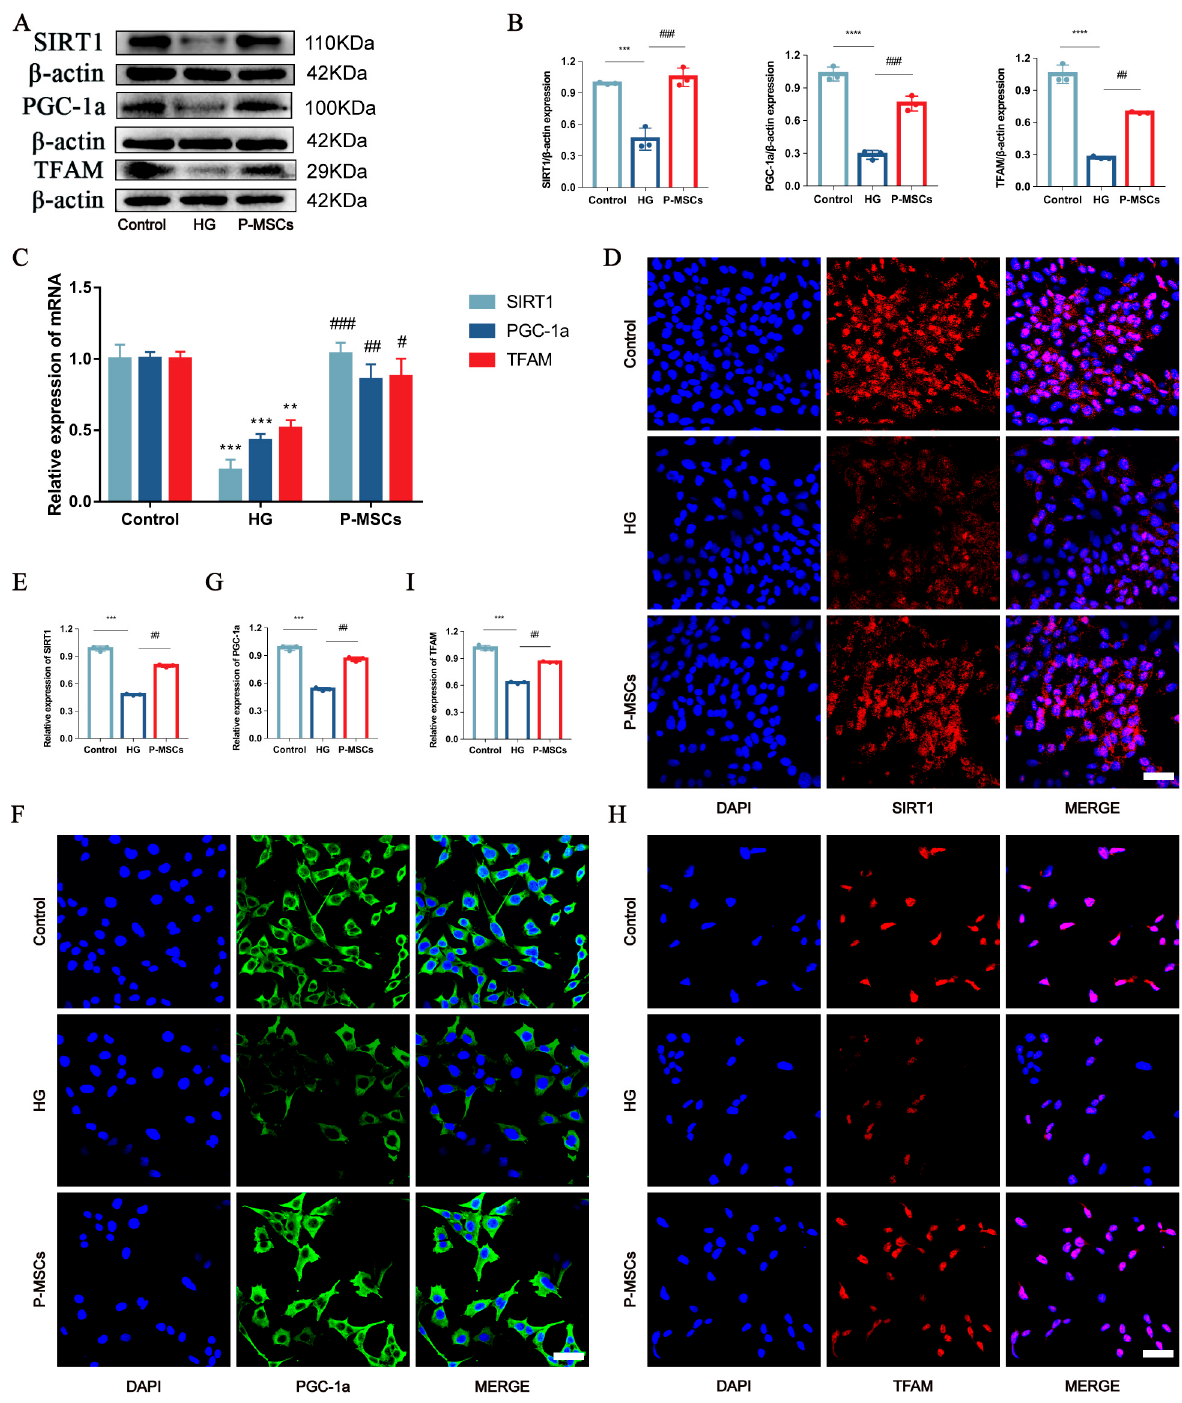
Figure 5. P-MSCs increased the expressions of SIRT1, PGC-1a, and TFAM in MPC5. Figure 5. P ‐ MSCs increased the expressions of SIRT1, PGC ‐ 1a, and TFAM in MPC5. ( A , B ) Repre ‐ ( A , B ) Representative Western blot analysis of SIRT1, PGC-1a, and TFAM in MPC5. ( C ) Repre- sentative Western blot analysis of SIRT1, PGC ‐ 1a, and TFAM in MPC5. ( C ) Representative RT ‐ PCR sentative RT-PCR analysis of SIRT1, PGC-1a, and TFAM in MPC5. D-I: Immunofluorescence staining analysis of SIRT1, PGC ‐ 1a, and TFAM in MPC5. D ‐ I: Immunofluorescence staining of SIRT1, PGC ‐ of SIRT1, PGC-1a, and TFAM in MPC5 (Magnification, 400 × ). Scale bars: 50 µ m for ( D , F , H ). n = 3 for ( A – I ). Values are expressed as the mean ± SD. B-actin was used as loading control. ** p < 0.01, *** p < 0.001, and **** p < 0.0001 vs. control, # p < 0.05, ## p < 0.01, and ### p < 0.001 vs.